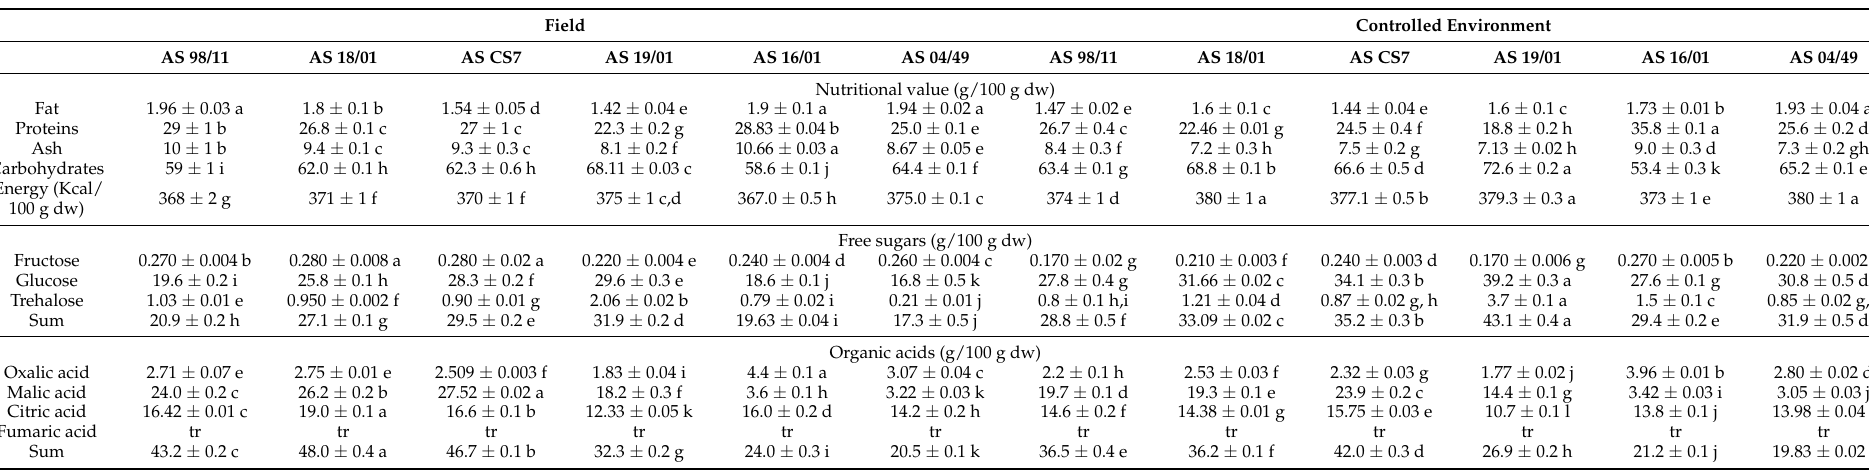
Table 1. Nutritional, energetic value and hydrophilic compounds of the studied Agaricus subrufescens samples produced in the field and in controlled environment